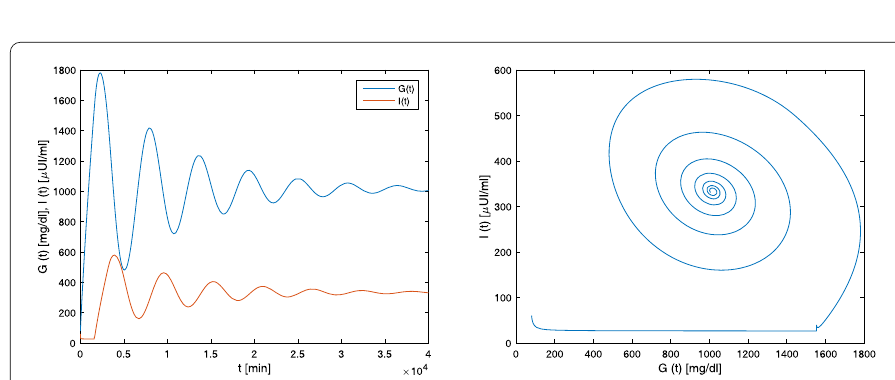
Figure 6 Time series and phase portrait of fractional-order model (29) generated using the information from Set 3, the parameter values in Eq. (58), and τ = 1500 > τ 0 = 1285.910. A periodic oscillation bifurcates from the equilibrium point ( G ∗ , I ∗ ) = (686.41,362.92)